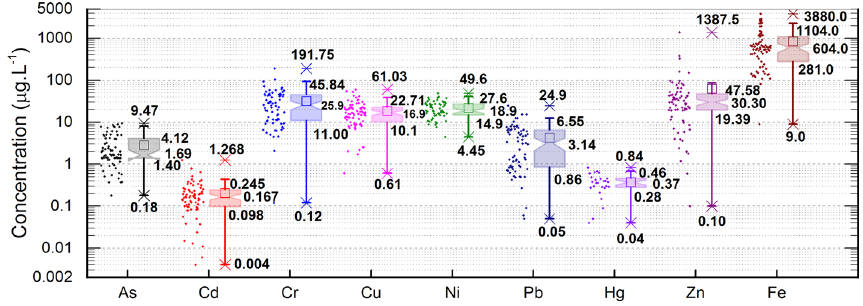
Fig. 2 Box–Whisker plot of concentrations of the metal ions. Dots represents the concentration of respective metals in measured sam- ples. The top and bottom of boxes cover a quartile range from 25 to 75th percentile. Whiskers in the form of outliers represent the outer- most data point falling within upper inner and lower inner fences. The